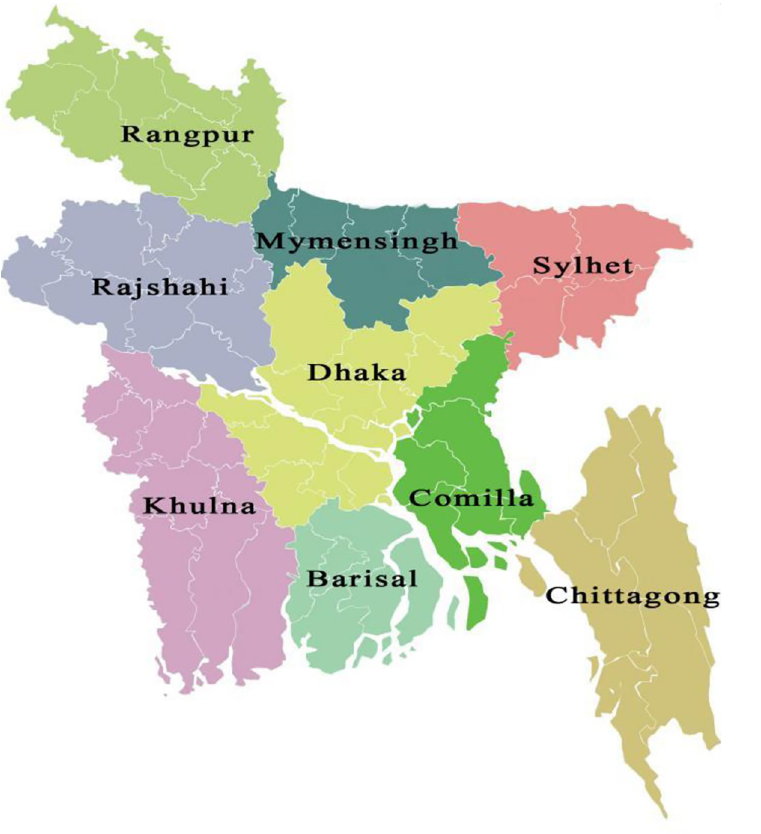
Fig 1. Map of the objective regions of